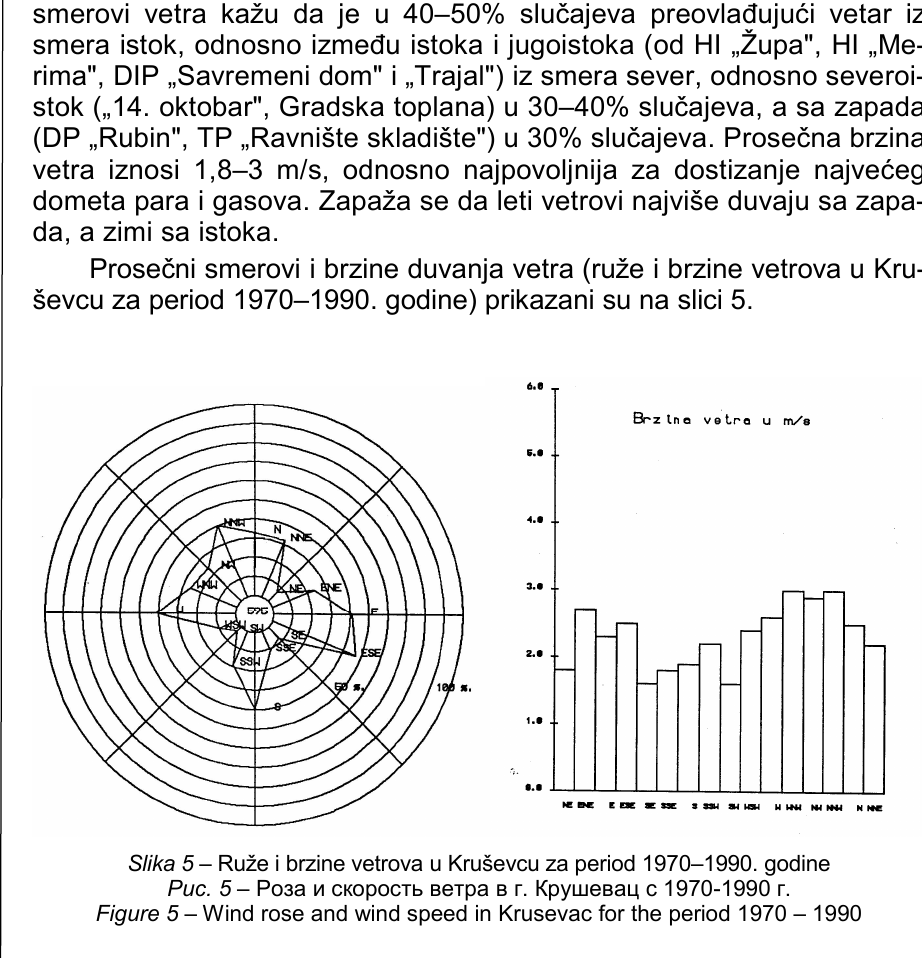
Figure 5 – Wind rose and wind speed in Krusevac for the period 1970 –